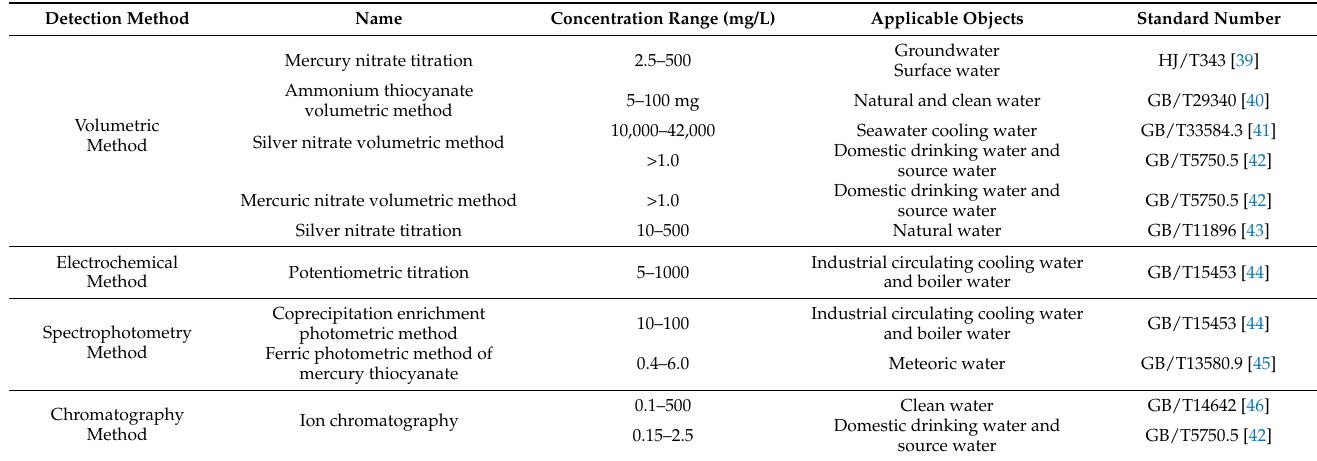
Table 1. Typical detection standards for chloride ion in water in